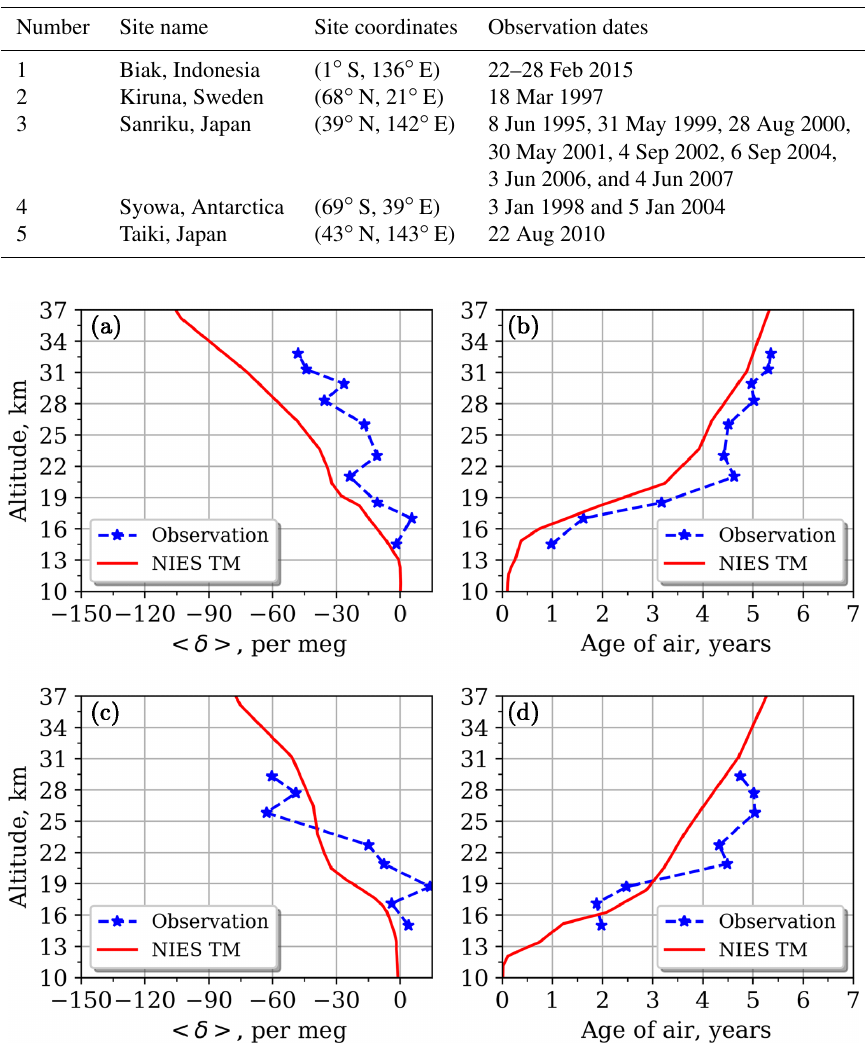
Figure 5. Vertical profiles over Sanriku of (cid:104) δ (cid:105) (per meg) (a, c) and AoA (years) (b, d) calculated from the modeled “surface” tracer (in red) and the observed CO 2 (in blue) distributions for 4 June 2007 (a, b) and 28 August 2000 (c, d)